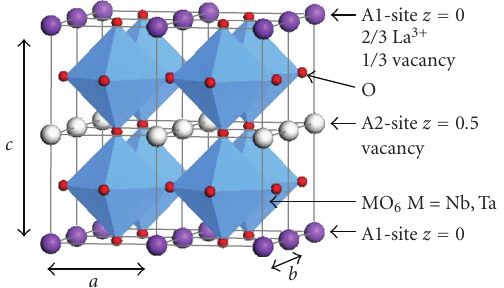
Figure 2: Crystal structure model of La 1 / 3 MO 3 (M = Nb, Ta).